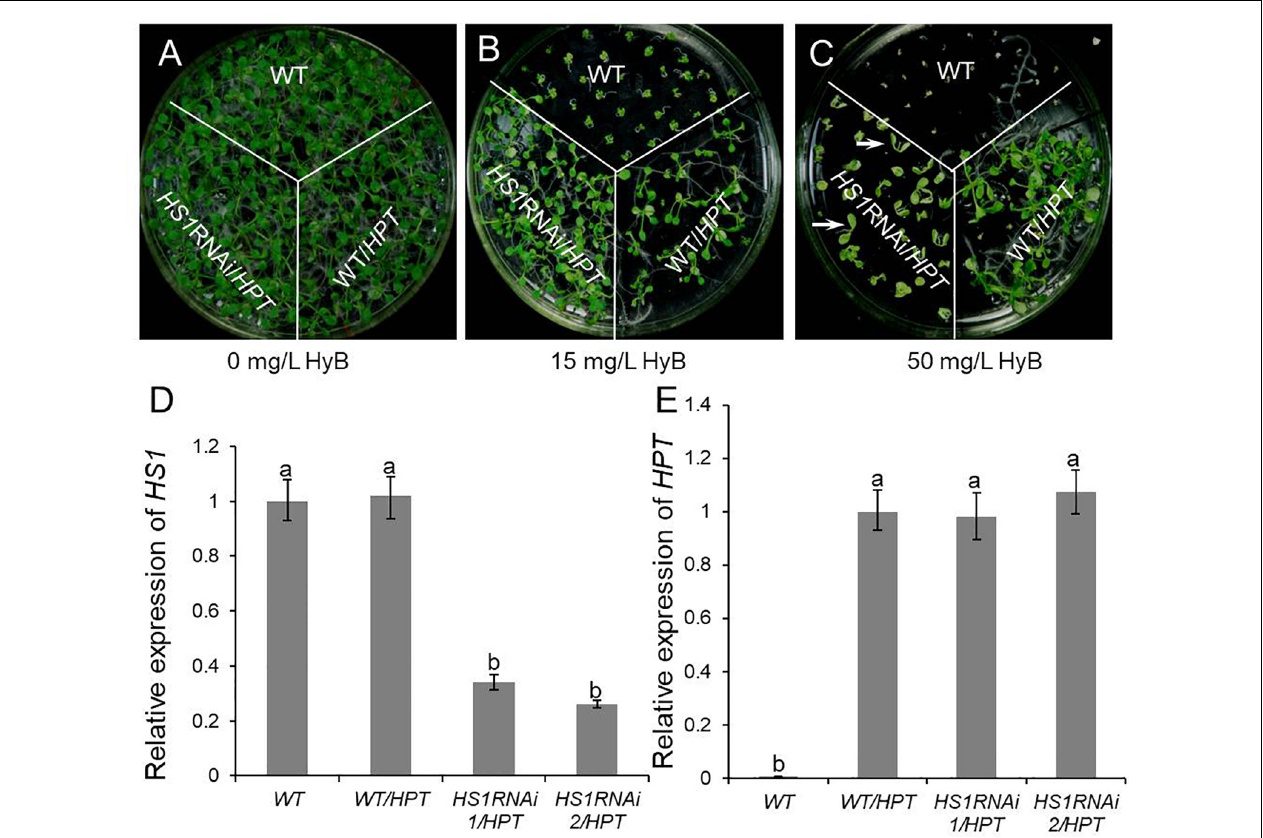
FIGURE 2 | Knockdown of HS1 increases the sensitivity to hygromycin B in transgenic plants. Ten days seedlings of WT (Col-0), HS1 RNAi mutants, and empty vector transgenic control (WT/ HPT ) respond to hygromycin in 0 mg/L (A) ,15 mg/L (B) , and 50 mg/L (C) containing plates. All plants had normal growth on medium without hygromycin B. HS1 RNAi/ HPT plants grew similar to empty vector transgenic plants on 15 mg/L hygromycin B medium, whereas growth of the WT was repressed. HS1 RNAi/ HPT plants (arrowhead) did not grow true leaves on medium with 50 mg/L hygromycin B, whereas transgenic control plants grew normally. (D) and (E) are quantitative PCR expression analysis of HS1 (D) and HPT (E) using ACTIN as reference in the WT, HS1 RNAi/ HPT mutants, and empty vector transgenic plants which grew on 0.5 × MS medium without hygromycin. Although HS1 expression was silenced in HS1 RNAi/ HPT plants, HPT expression was similar in transgenic control and RNAi mutants. Similar results were obtained in three independent experiments. For each column in (D) and (E) , different letters a , b indicates significant differences at P <